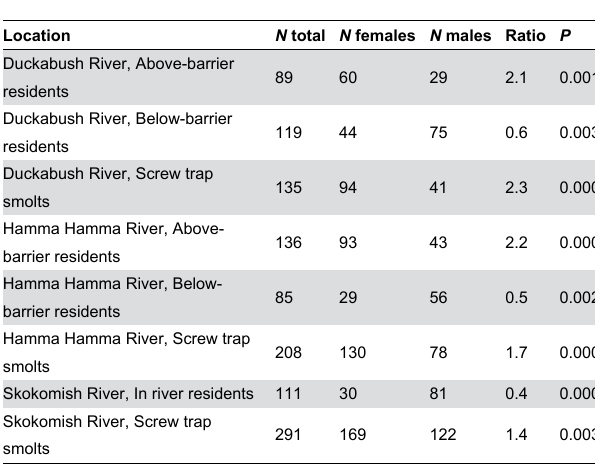
Table 3. Total number of female and male O. mykiss found in each sampling location, the female : male ratio, and the probability that the observed sex ratio is